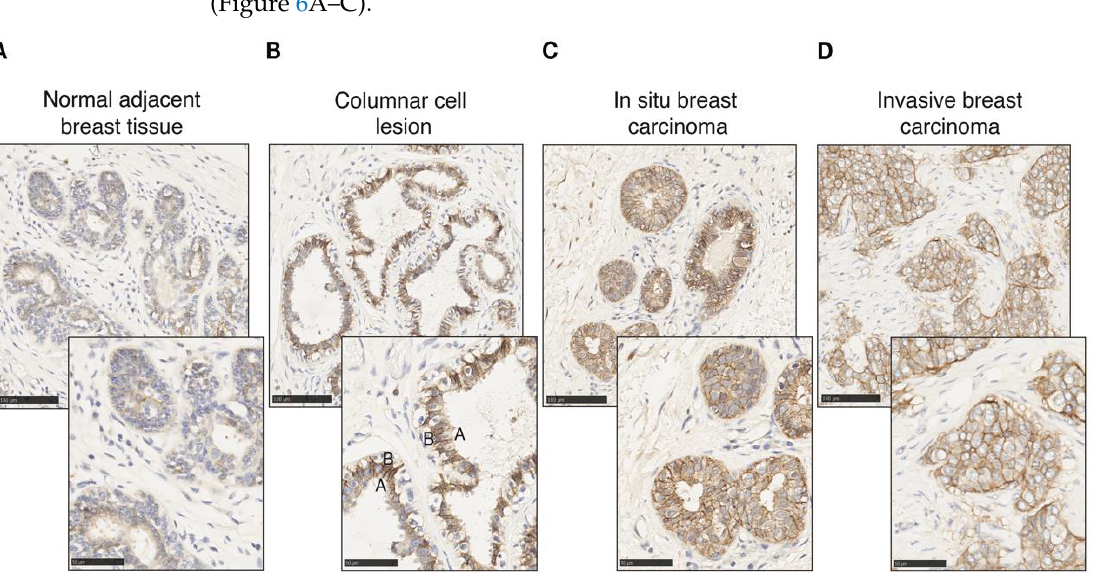
Figure 6. Protein expression levels of CAXII and of the luminal transcription factors ERα, FOXA1 and GATA3 are correlated in breast tumors. Correlations between CAXII and ERα ( A ), GATA3 ( B ) or FOXA1 ( C ) expression scores are shown for all tumors in the TMAs. Scores were computed by QuPath using membrane (CAXII) and nuclear signal intensities (ERα, GATA3, FOXA1). ER + PR + tu- mors are highlighted in dark blue circles, ER + PR − tumors in light blue circles, ER − PR + tumors in yel- low diamonds, ER − HER2 + tumors in green squares and ER − HER2 − tumors in red circles. Representa- tive co-staining for CAXII (brown) and each of these luminal transcription factors (green) is also shown. 3.7. CAXII Is Mainly Expressed in ER + Breast Tumors CAXII score distributions within each clinical tumor subtype indicate that in 72 ER + tumors, 71 (98.6%) were positive for CAXII. In these tumors, the 55 ER + PR + and the 17 ER + PR − have significantly higher scores for CAXII expression compared to ER − HER2 + and TN clinical tumors (Figure 7A). However, no significant difference in CAXII scores was observed between ER + PR + and ER + PR − tumors. The only ER + tumor negative for CAXII (score 2.3) is also negative for PR, suggesting low or absent ERα activity. Conversely, 7 out 9 ER − HER2 + tumors and all 34 TN tumors (ER − PR − HER2 − ) are negative for CAXII